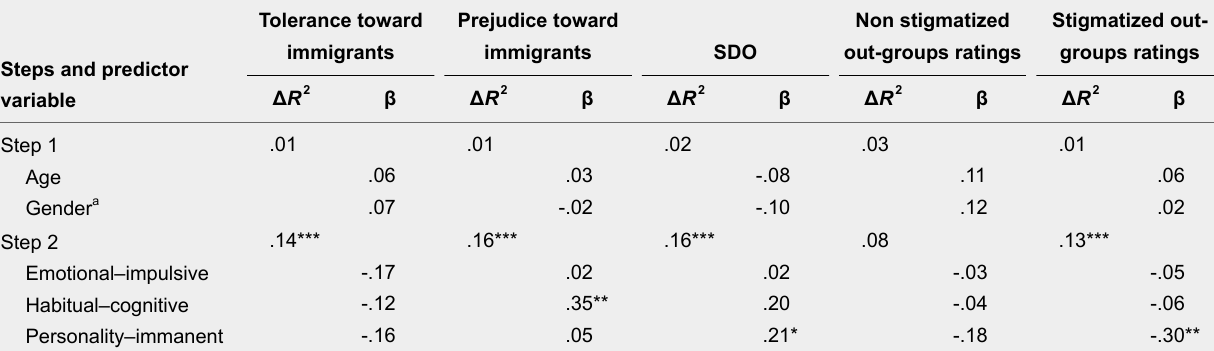
Regression Models Predicting Tolerance, Prejudice, SDO and Out-Groups Ratings